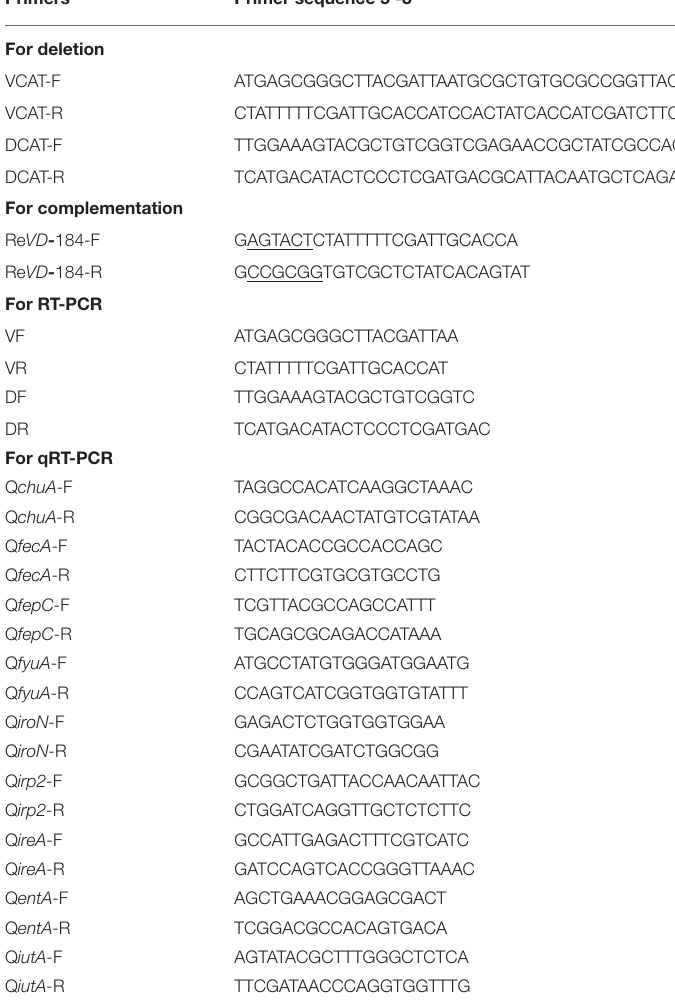
TABLE 2 | Primers designed and used in this study.